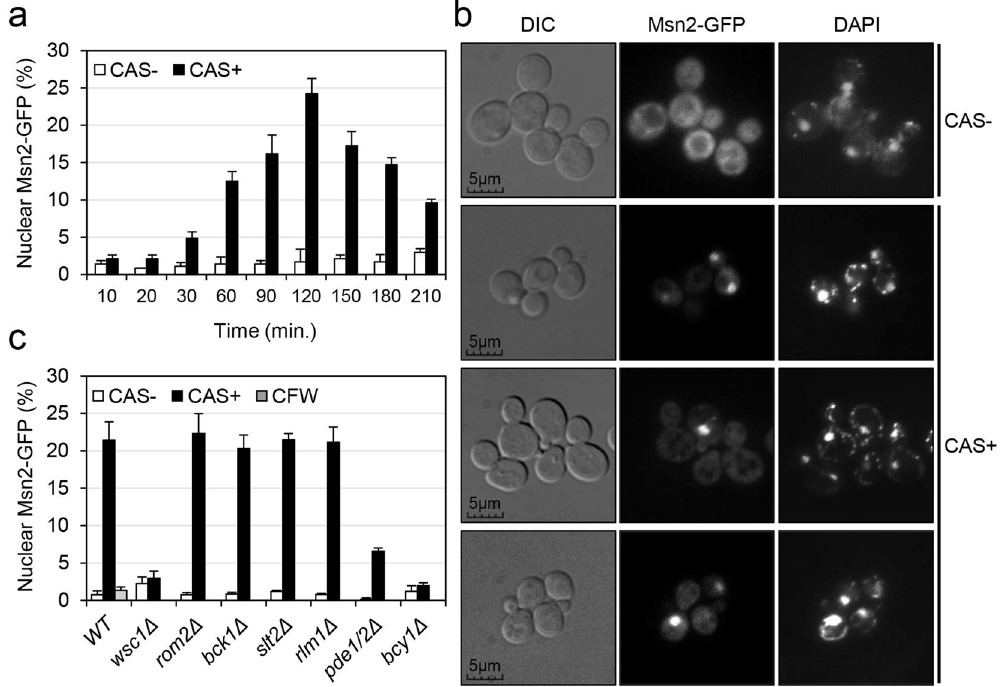
Figure 3. Caspofungin treatment triggers nuclear entry of the Msn2 transcription factor. ( a ) Histogram depicts the percentage of cells showing nuclear Msn2-GFP localisation in the wild-type strain at the indicated times of CAS (15 ng/ml) exposure. ( b ) Exponential cultures of the wild-type BY4741 (WT) strain expressing Msn2-GFP were subjected (CAS + ) or not (CAS − ) to CAS (15 ng/ml for 2 h), collected, and studied under fluorescence microscopy. Staining with DAPI is also shown. In living cells, DAPI stains mitochondrial and chromosomal DNA. ( c ) Histogram depicts the percentage of cells showing nuclear Msn2-GFP in the wild-type and the indicated mutant strains grown in the presence or absence of CAS over 2 h. Nuclear localisation of Msn2-GFP after Calcofluor white treatment (CFW, 5 µ g/ml for 2 h) was also measured for the wild-type strain. Values represent the average and SD calculated from three independent experiments (at least 300 cells were analysed for each independent